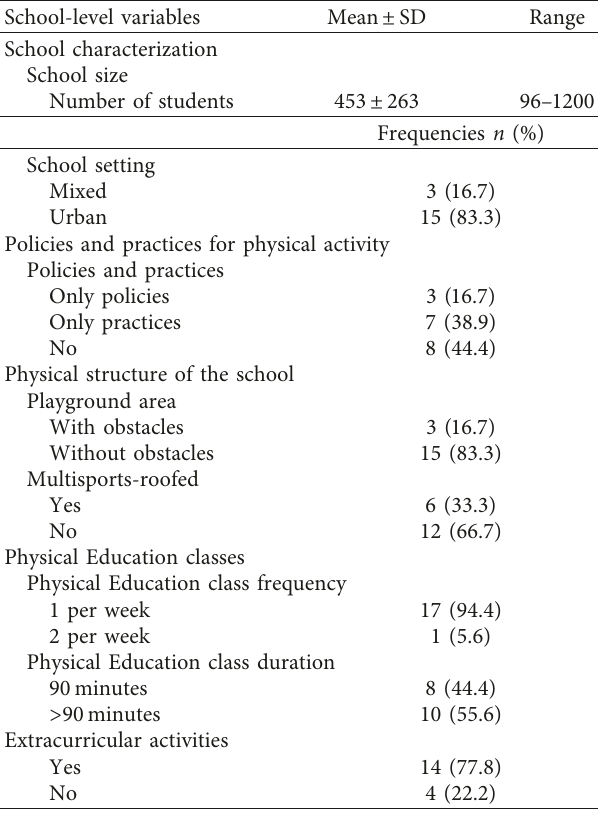
Table 5: Descriptive statistics for school-level